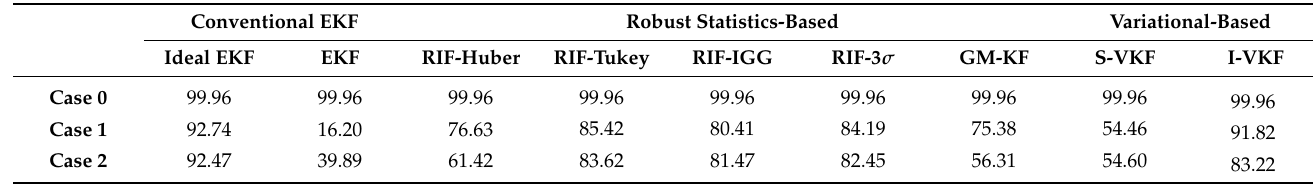
Figure 7. Empirical cumulative distribution function (CDF) of the float positioning errors for cases 1 ( left ) and 2 ( right ). Table 2. Percentage of successful fixed solutions